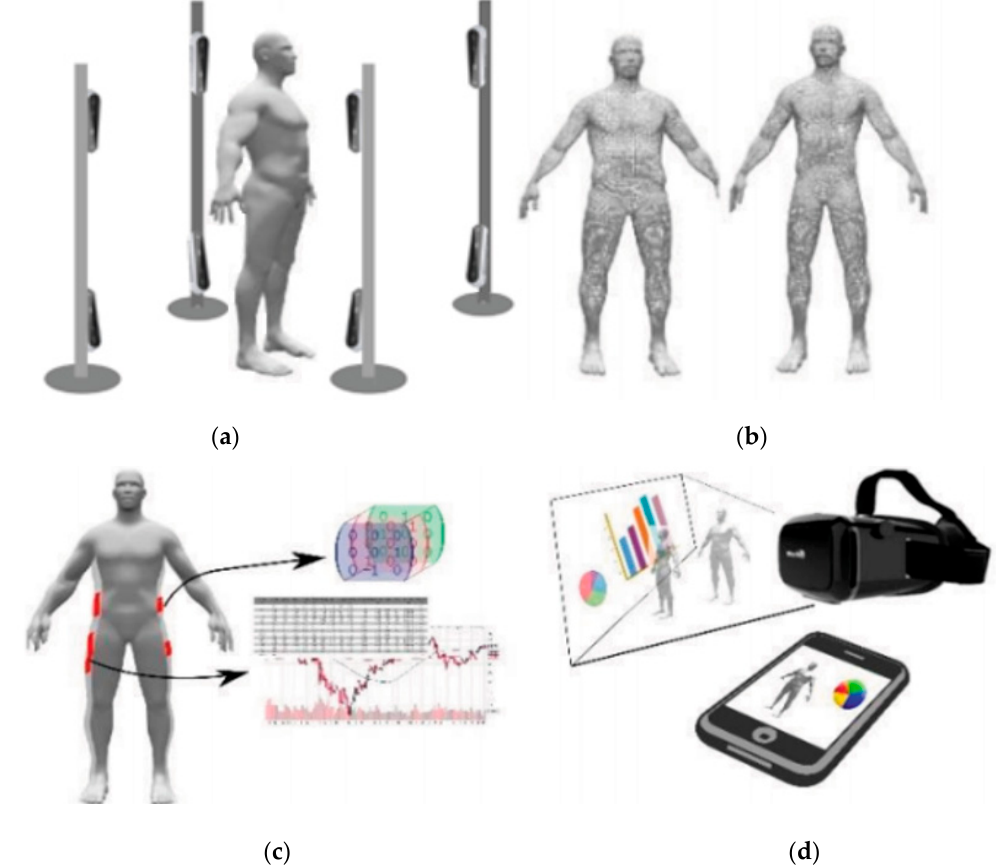
Figure 1. Acquisition system based on RGB-D camera network ( a ). Body models: point clouds and mesh ( b ). Shape evolution analysis ( c ) and textured representation with virtual reality (VR) devices ( d ).